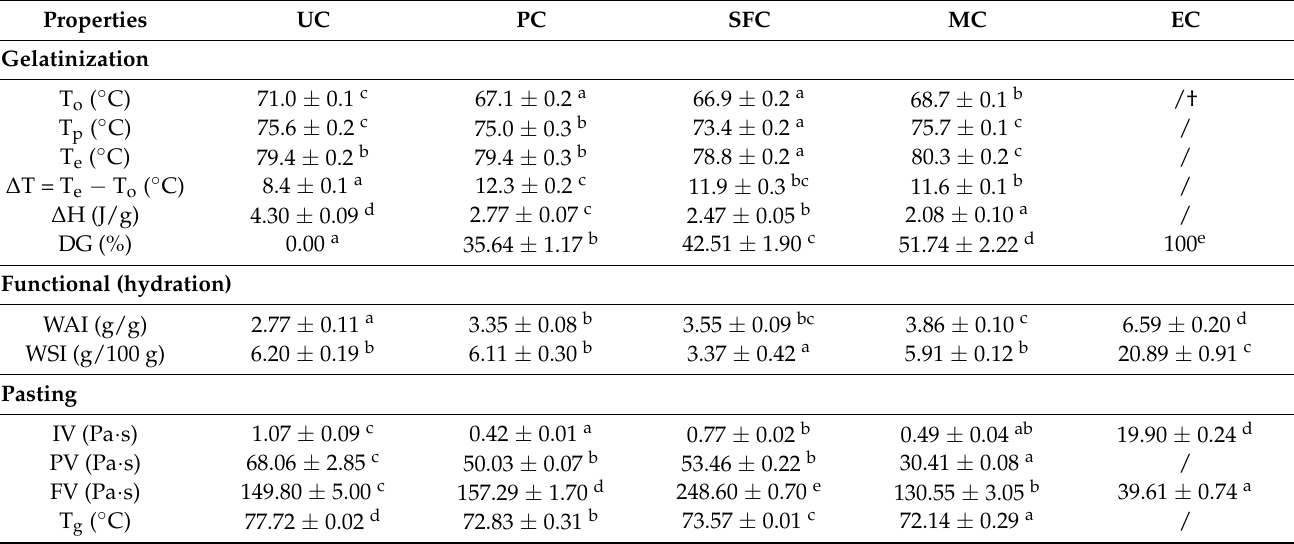
Table 1. Gelatinization, functional, and pasting properties of unprocessed and heat-treated